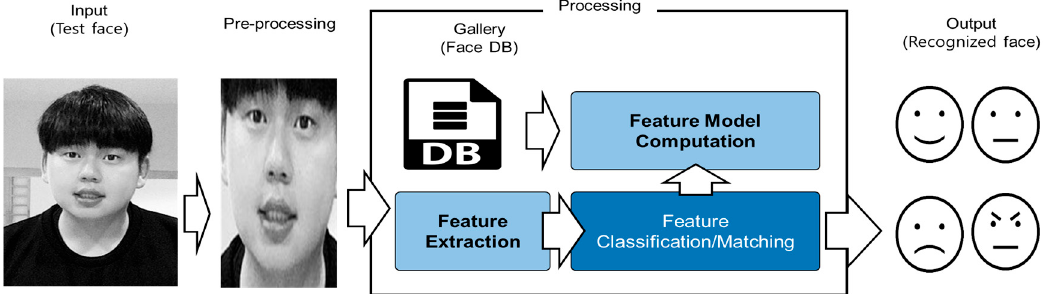
Figure 2. Facial recognition algorithm using a face database. * The figure included in this image is the author, who agreed to provide the figure.